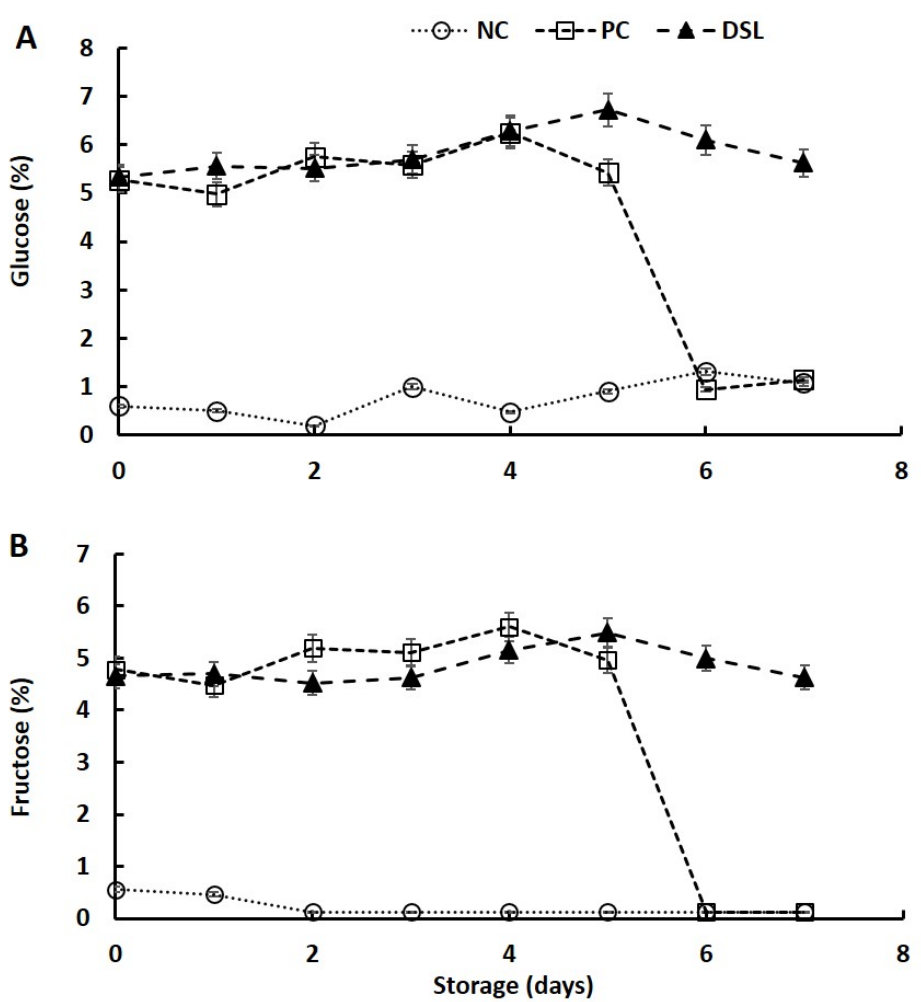
Figure 2. Changes in glucose ( A ) and fructose ( B ) content of date syrup-fortified laban (DSL), positive control (PC), and negative control (NC) drinks during cold storage at 4 °C for 7 days.